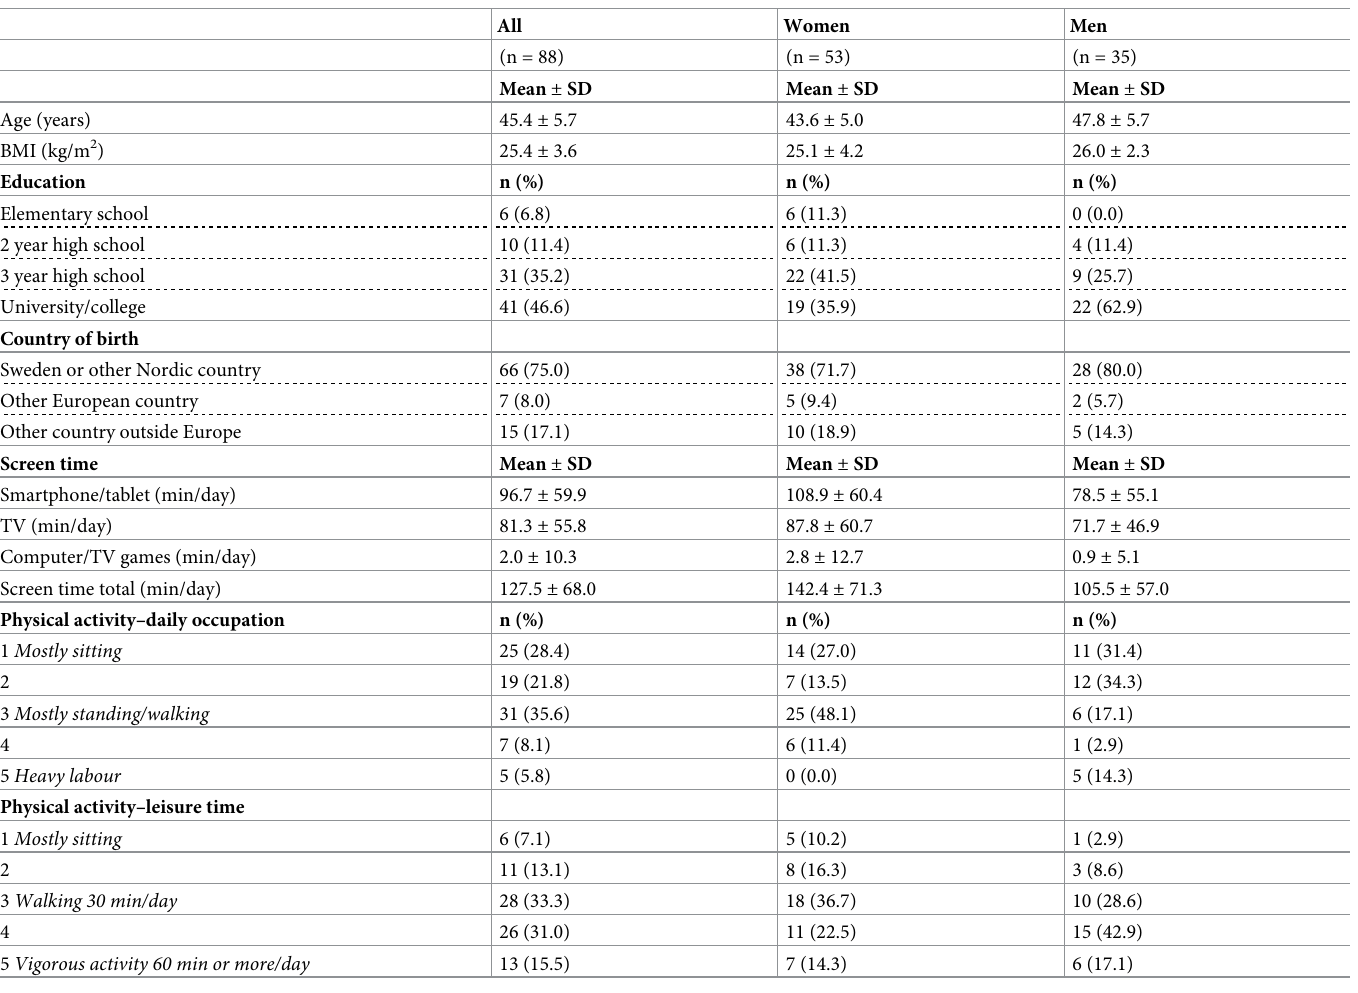
Table 2. Characteristics of